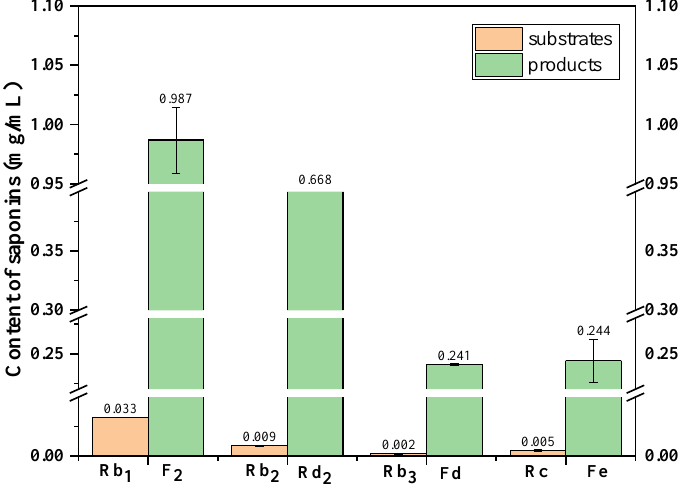
Figure 5. The contents change of ginsenosides F 2 and Rd 2 and notoginsenosides Fd and Fe from 211 the transformation products of ginsenosides Rb 1 , Rb 2 , Rb 3 , and Rc by C. xylophilum .